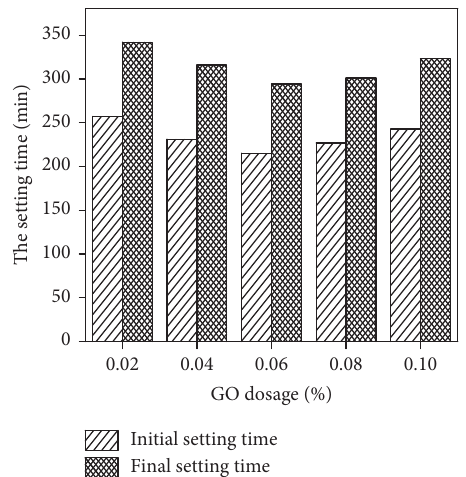
Figure 6: Setting time of CEAP with different GO